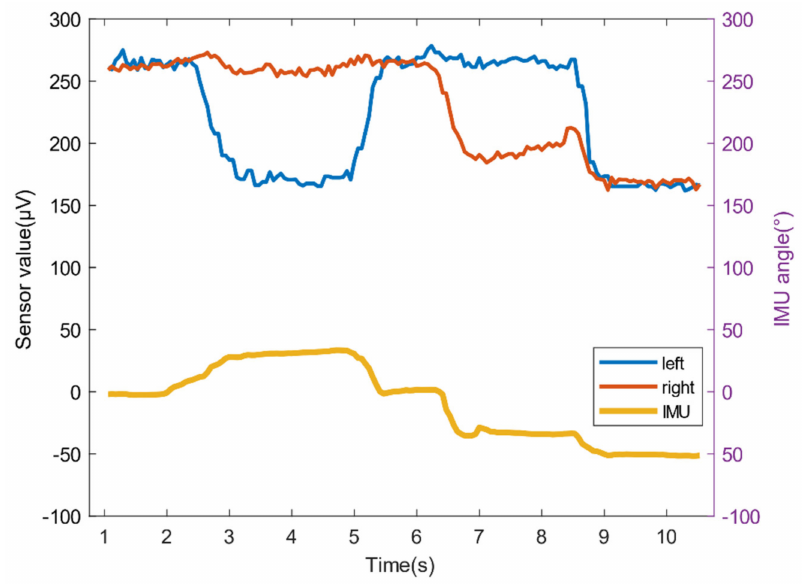
Figure 17. The relationship between the head swing angle and the sensor value